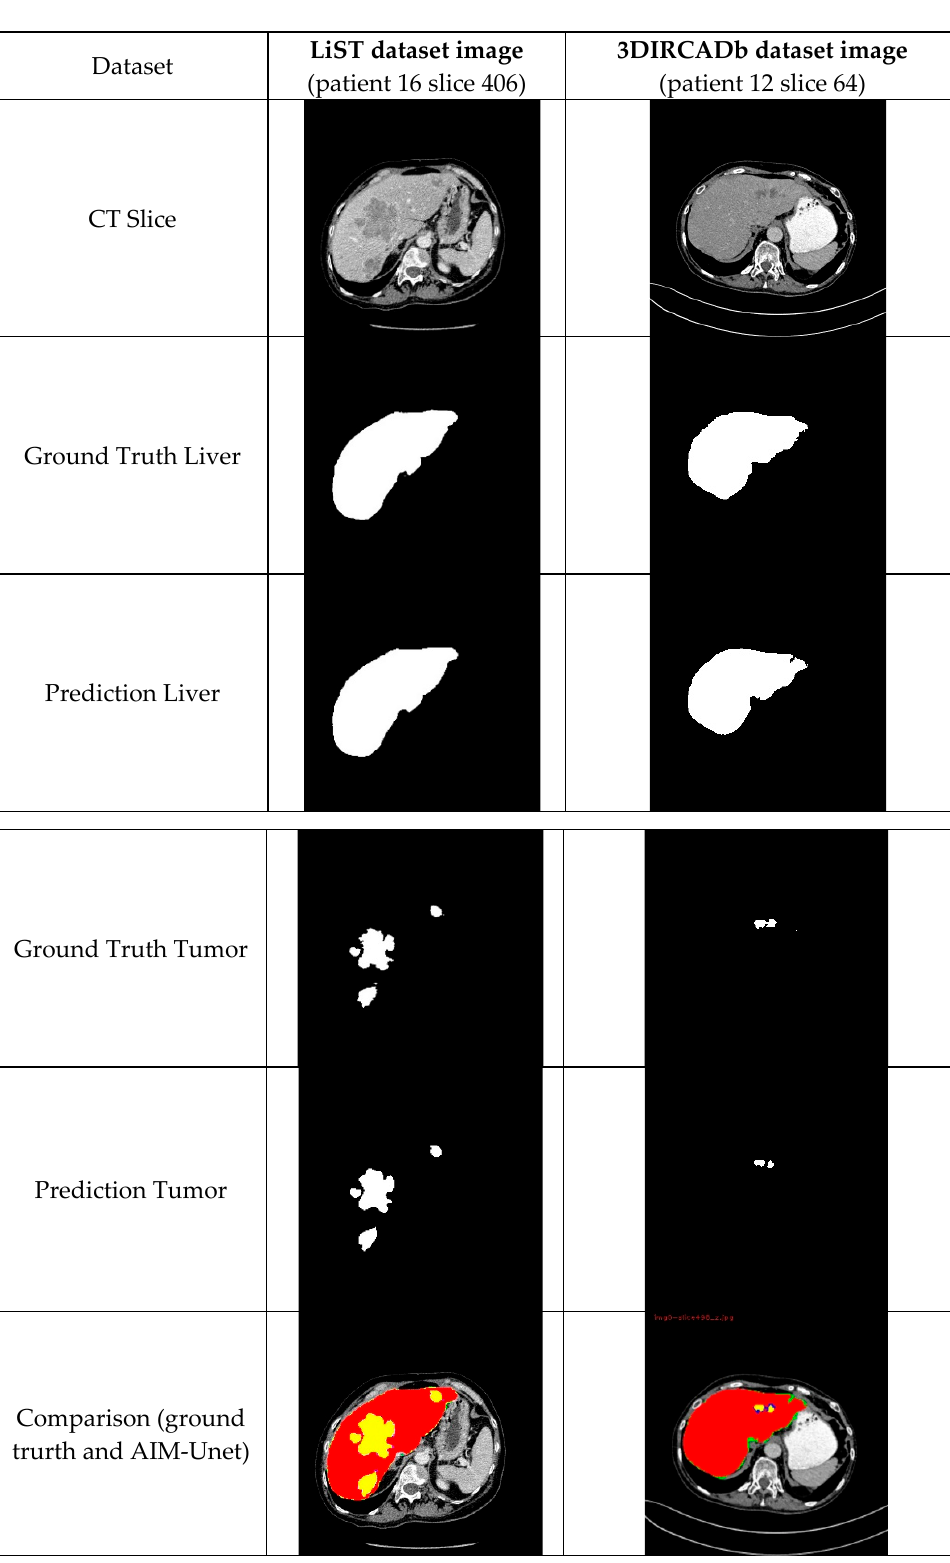
Figure 8. Performance of the proposed model (AIM-Unet) on images of datasets. The red areas in the comparison image show the regions that our model missed, the green areas are the areas that the model predicted incorrectly, and the yellow areas are the regions that the model predicted cor- rectly.